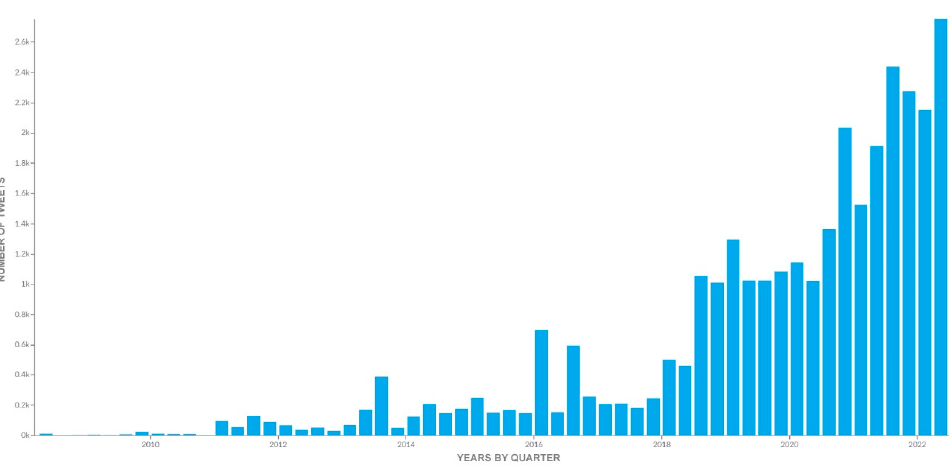
Figure 1. Number of tweets mentioning cultured meat from 1 January 2005 to 30 June 2022. The figure shows the continuous increase in cultured-meat-based communications on the social network Twitter.